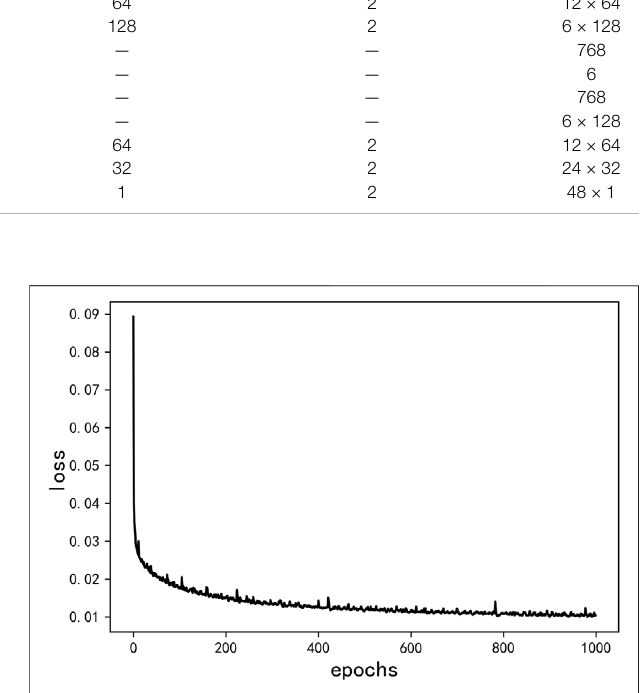
FIGURE 4 | The training